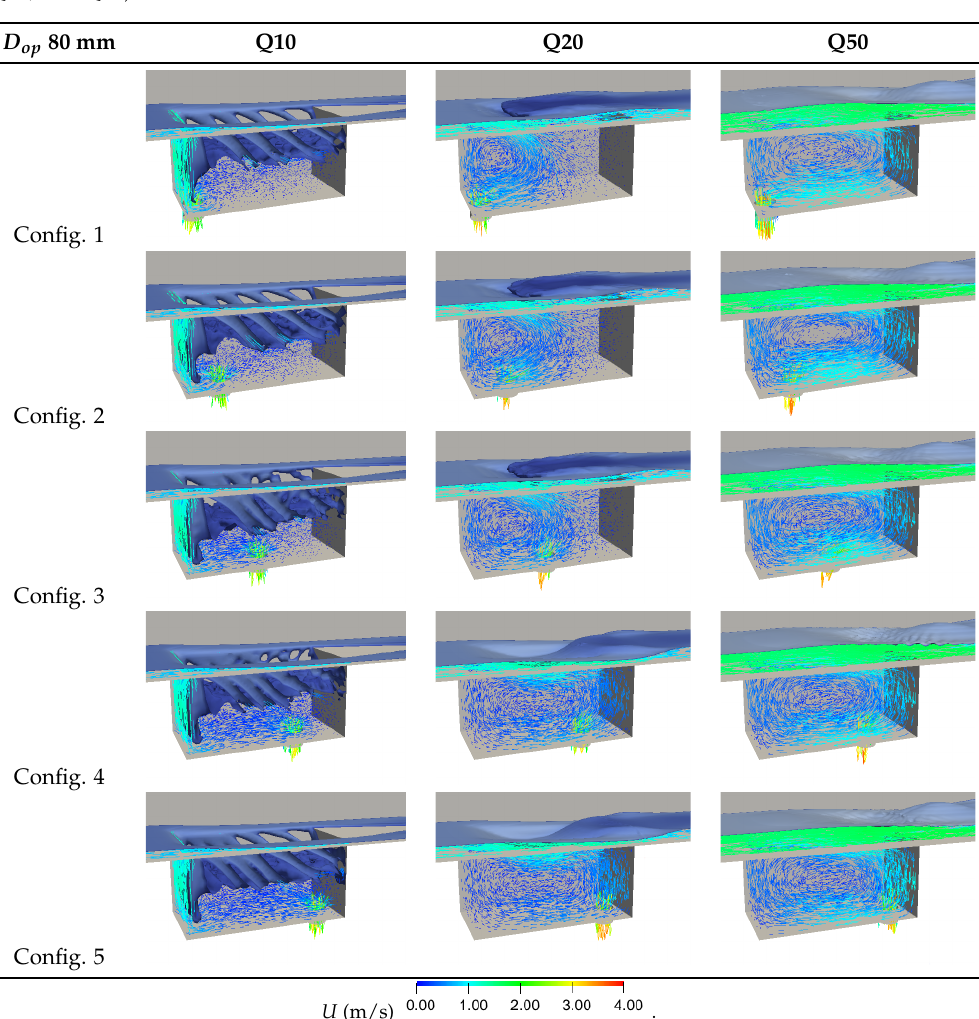
Table 6. Velocity field and free-surface configuration at steady conditions—Configurations 1 to 5 (Q10, Q20, and Q50).